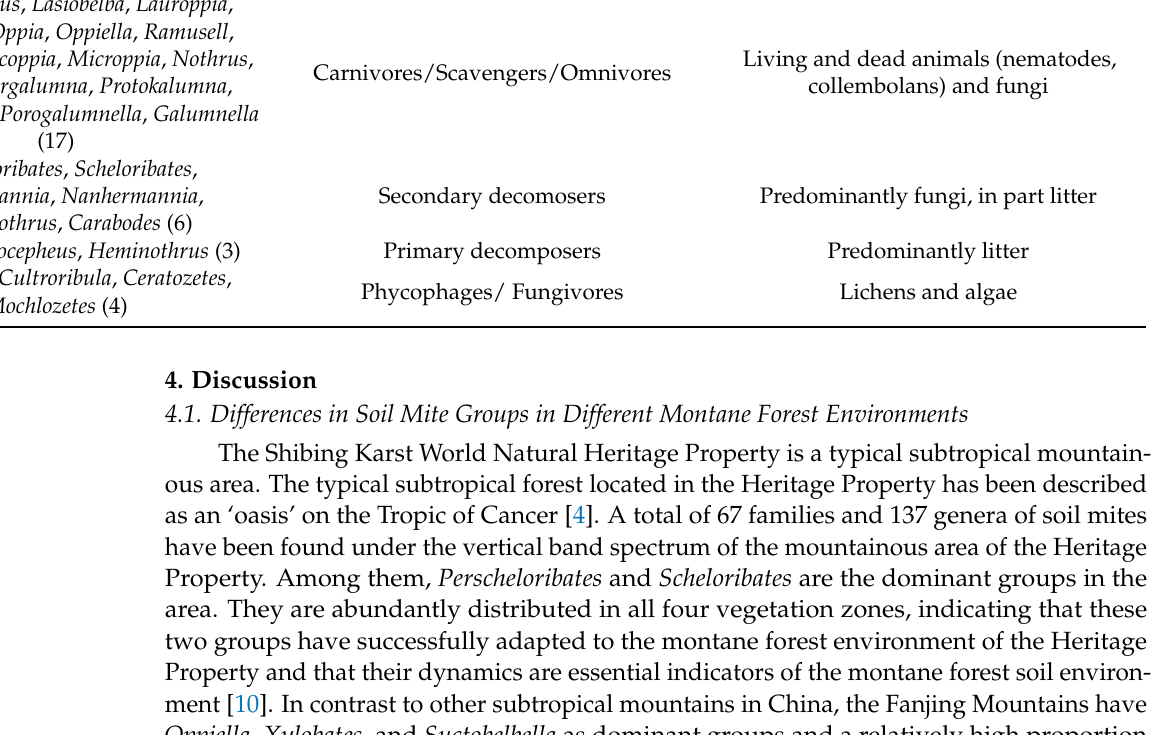
Table 9. Trophic structure of soil mites (Acari: Oribatida) in the study area. Oribatid Mite Groups Feeding Guild Food